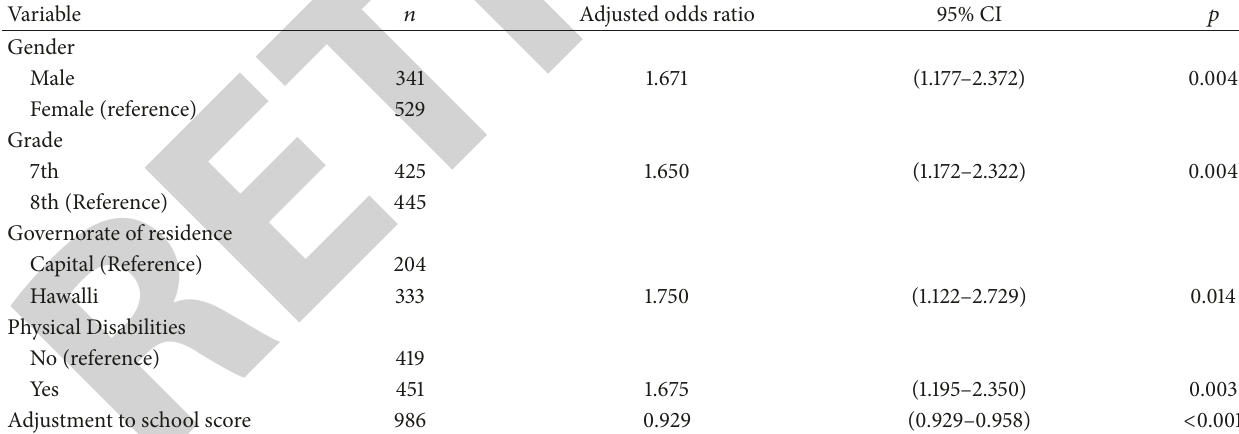
Table 4: Significant associated factors with bullying behavior using logistic